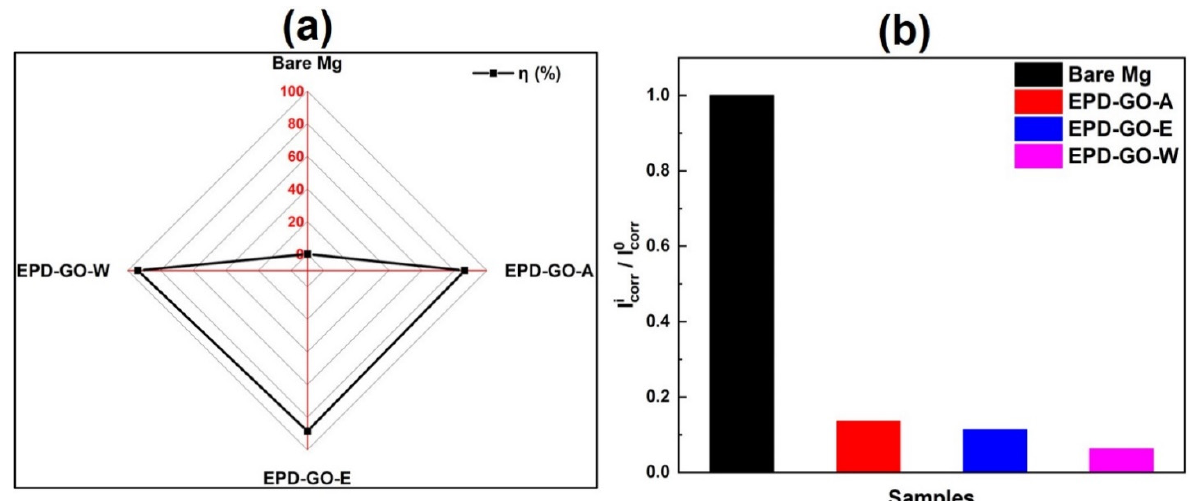
Table 1. Kinetic parameters obtained from Tafel